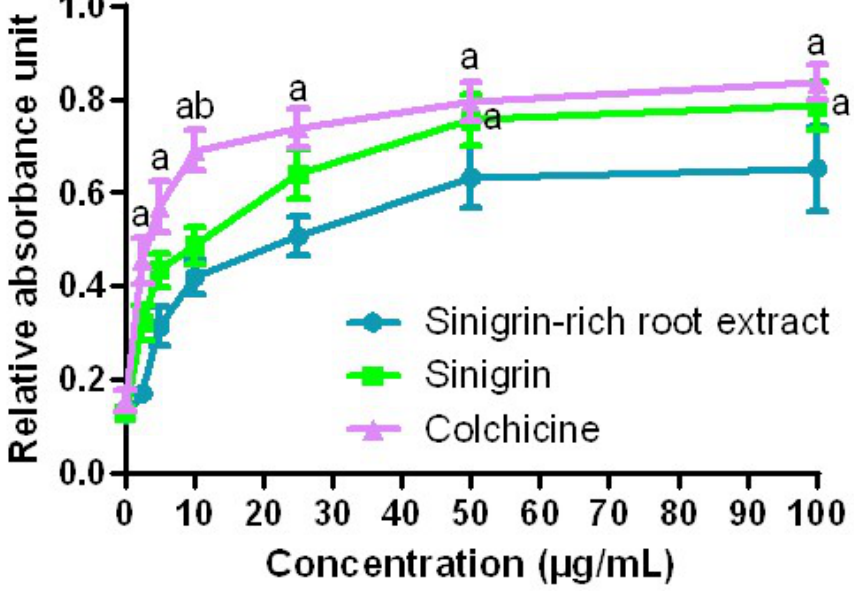
Figure 5. Effect of various concentrations (0, 2.5, 5, 10, 25, 50, and 100 µg/mL) of sinigrin-rich root extract, sinigrin, and colchicine on activities of caspase-3 in the DU-145 prostate cancer cells for 24 h. Values are represented as the mean ± SD ( n = 3). “a” Significant ( p < 0.01) difference from the sinigrin-rich root extract group and “b” significant ( p < 0.05) difference from the sinigrin group.